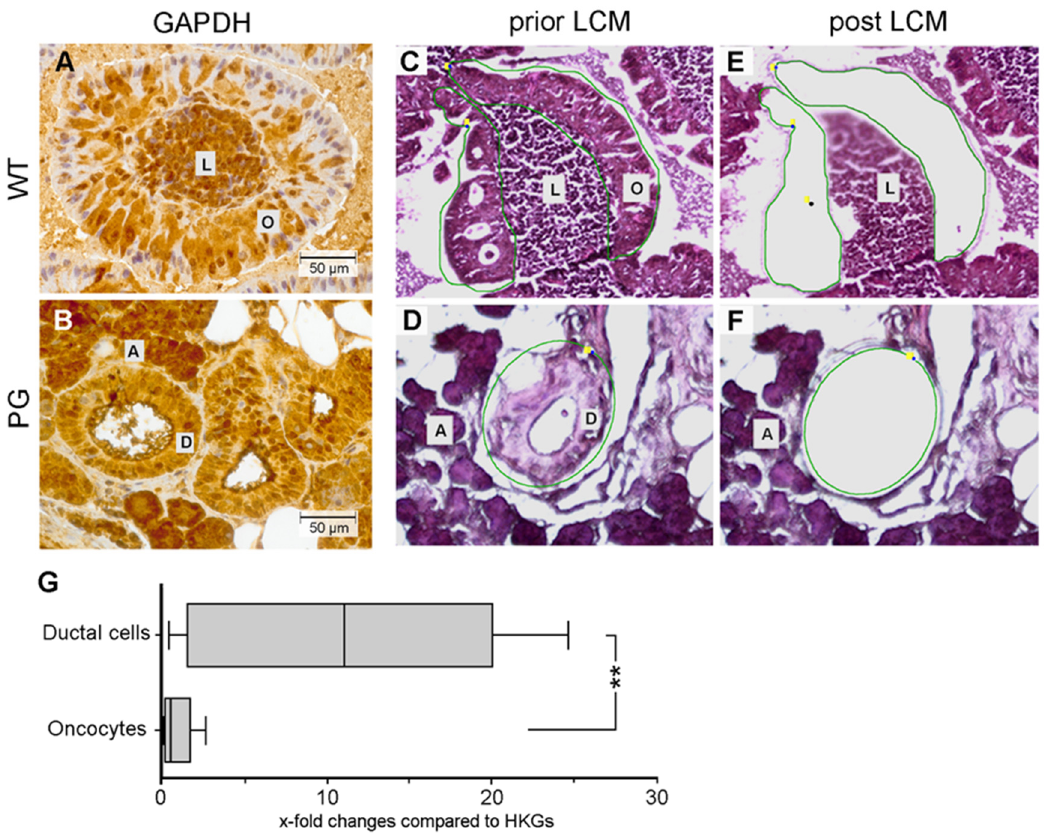
Figure 4. Evaluation of GAPDH mRNA levels in Warthin tumor oncocytes and normal ductal cells of the parotid gland. Representative GAPDH staining of Warthin tumor (WT) oncocytes ( A ) and normal parotid gland (PG) ductal cells ( B ). Areas of WT oncocytes ( C ) or PG normal ductal cells ( D ) were encircled (green lines) and captured by laser micro dissection ( E,F ). ( G ) Expression of GAPDH mRNA in comparison to the mean mRNA expression of the housekeeping genes (HKG) RPLP0 and RPL32 . Box-plot depiction of n = 8 PG and n = 8 WT samples. Statistical significance: ** p < 0.005. L = lymphocytes, O = oncocytes, A = acini, D = ductal cells.